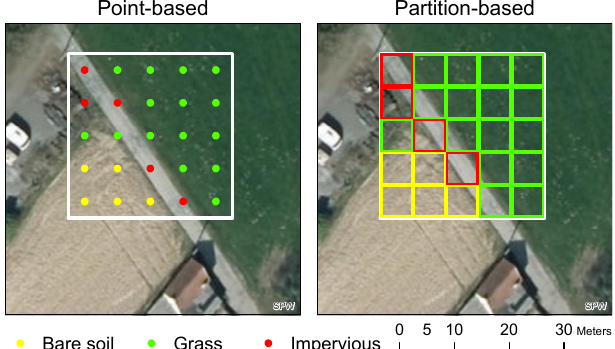
Figure 1. Two types of response designs compared in this study: point-based and partition-based designs. Grassland are in green, impervious surfaces are in red and ploughed bare soil are in yellow. Both methods would agree on most of the grassland, as well as the direct assignment of the majority class without looking at sub-samples, but it is worth noting that the proportions of impervious soil and grassland are not the